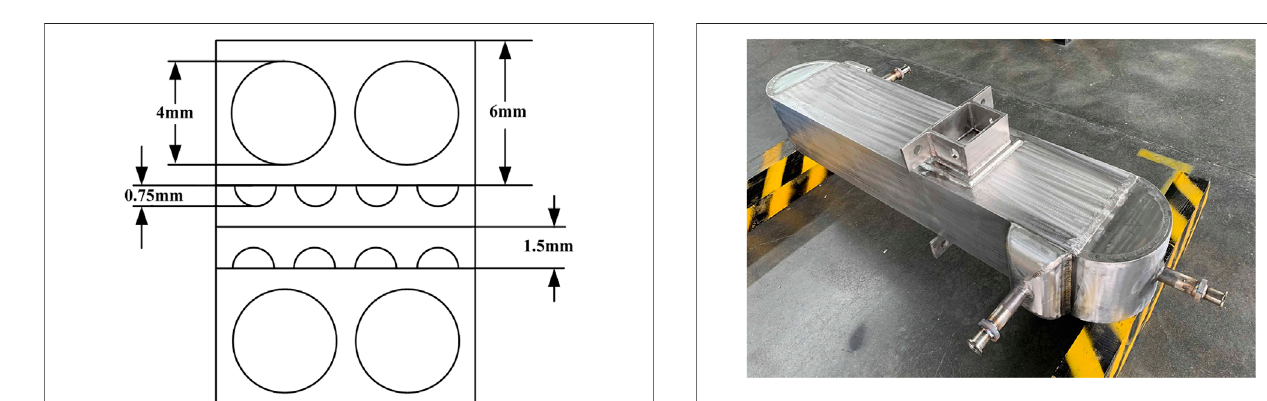
FIGURE 2 | Picture of PCHE prototype with heat transfer power of 50